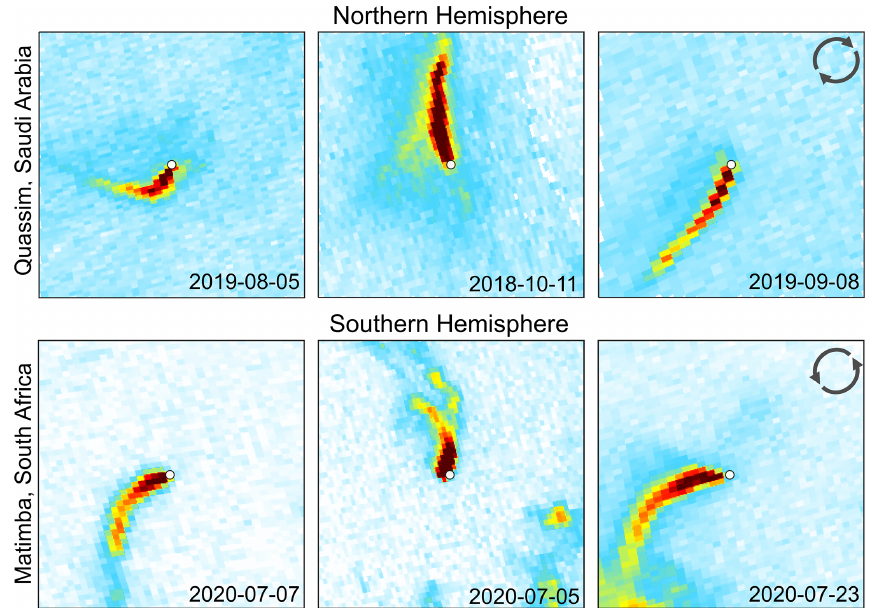
Figure 5. Example of the Coriolis influence on NO 2 emission plumes from daily TROPOMI NO 2 observations above Quassim (Saudi Arabia) and Matimba (South Africa). Power stations are shown as the central white dot in each observation.